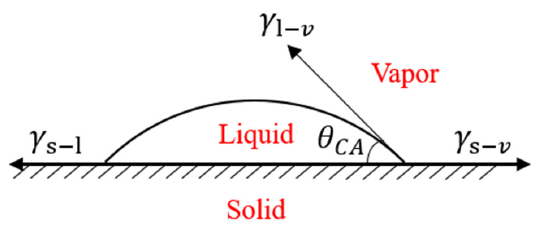
Figure 7. Contact angle diagram.